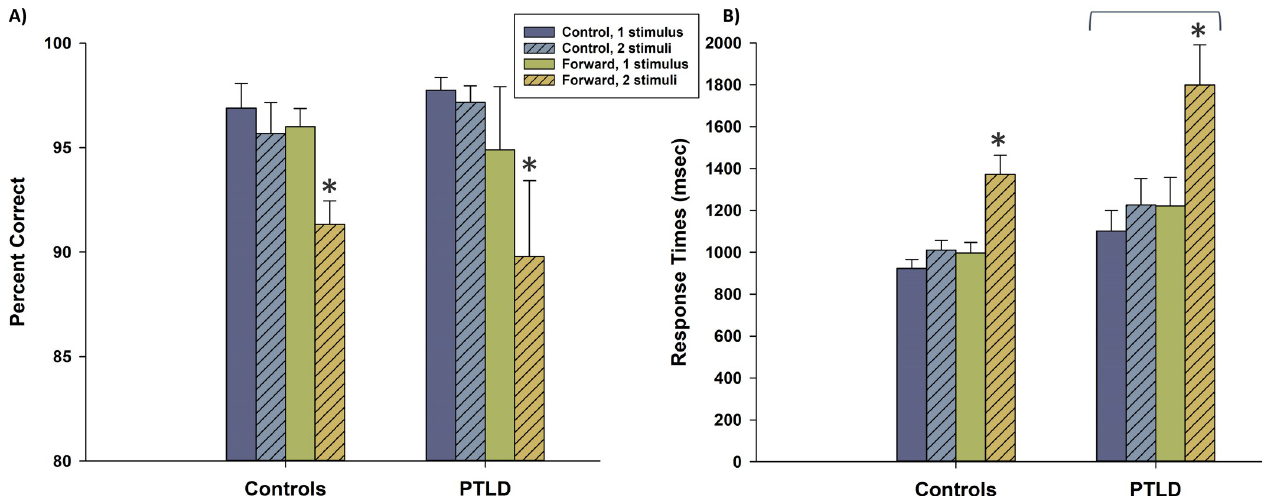
Fig 1. Behavioral performance on the fMRI working memory task. (A) Accuracy performance is presented, broken down by condition (control vs. forward), stimulus number (1 vs. 2 letters), and study group. Accuracy was particularly low for participants in the forward condition with two letters. However, accuracy performance did not differ overall between groups. (B) Response times for accurate trials are presented, as in (A). Response times were slowest in the forward condition with two letters. Overall, the PTLD group responded more slowly than did controls, as indicated by the overhead bracket. � indicates condition x stimulus interaction, p < .001; bracket indicates overall group difference, p = .037. Error bars denote one standard error.